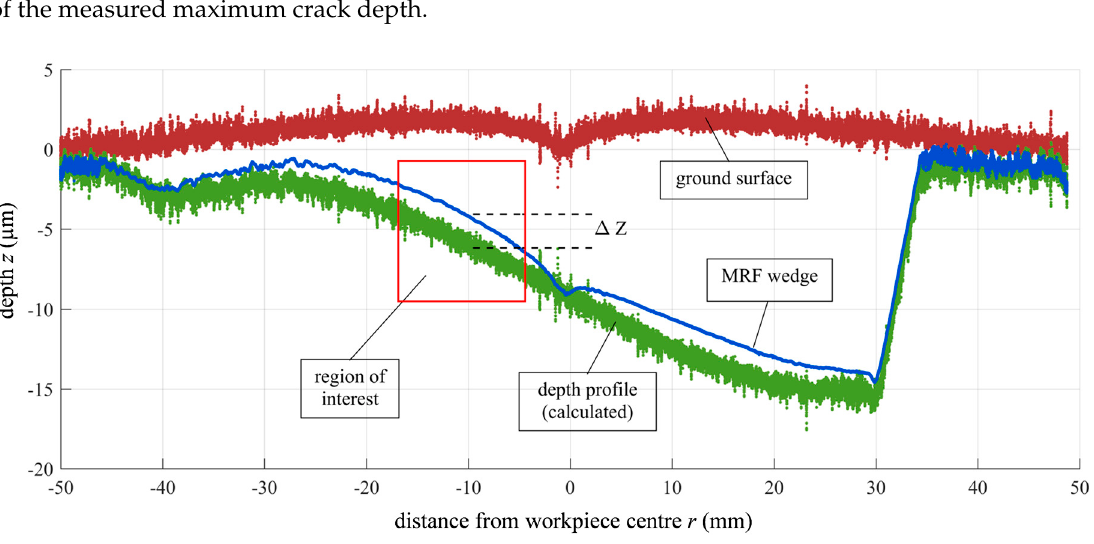
Figure 5. Tactile measurement of ground surface, MRF wedge and depth profile.